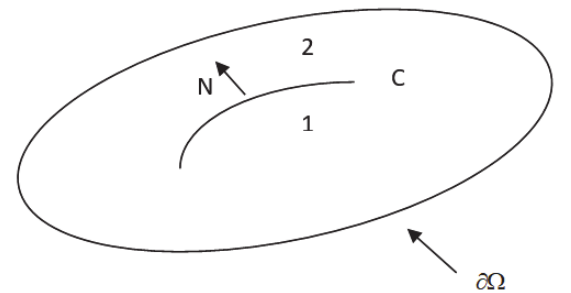
Figure 2: Representation of the fissured piezoelectric structure